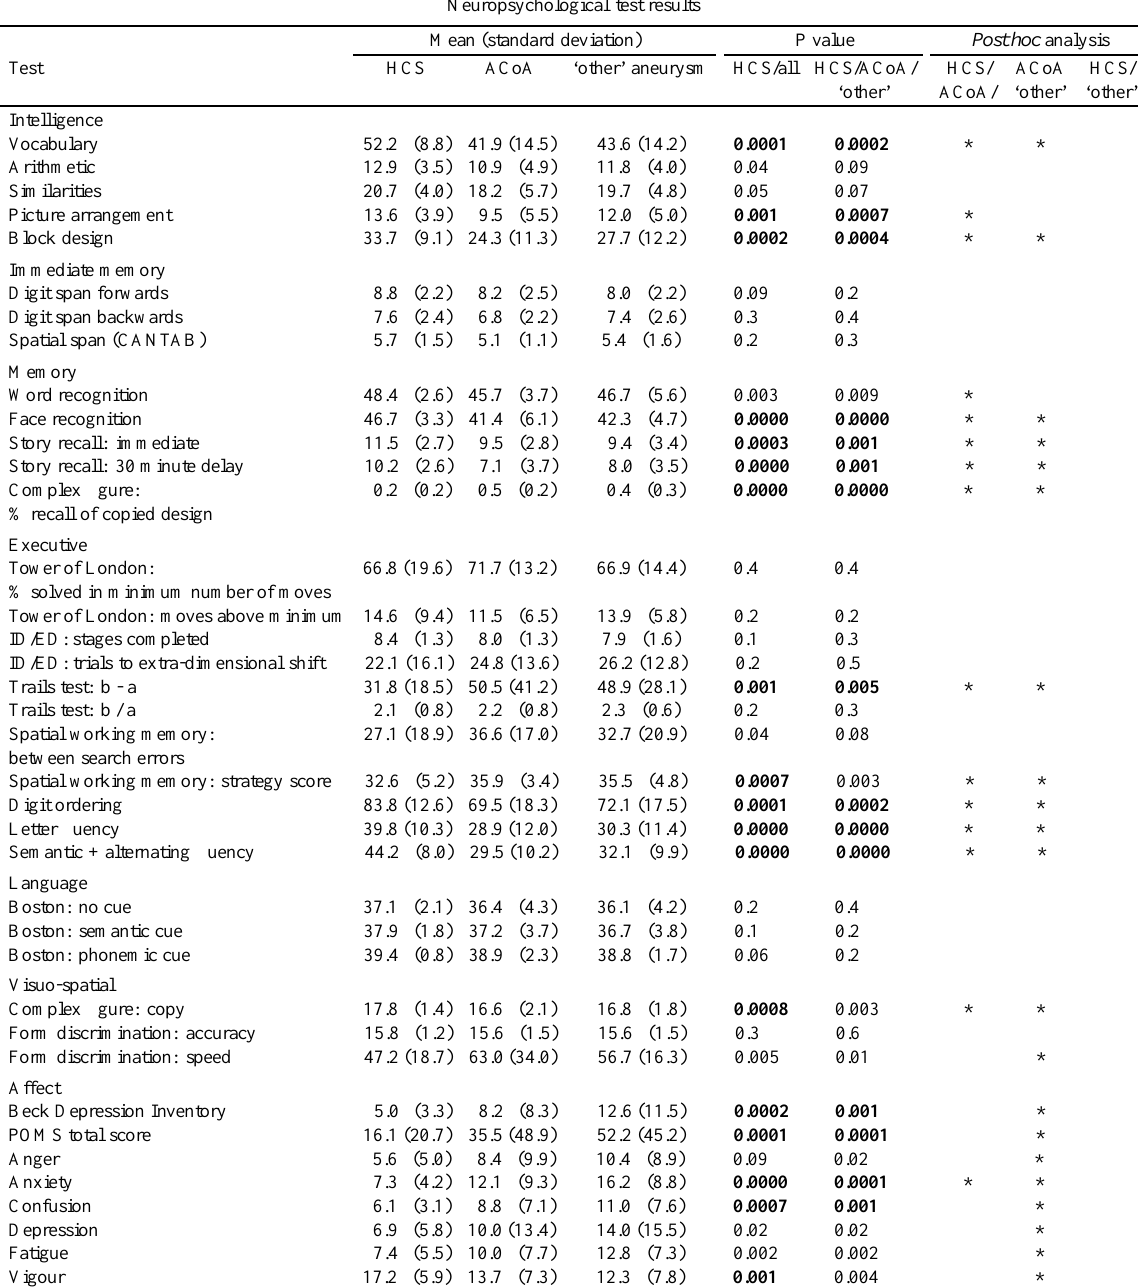
HCS: healthy control subjects. P values in bold indicate those that withstand Bonferroni correction for 37 comparisons. * indicate a significant difference at P < 0 . 05 according to Tukey’s hsd post hoc